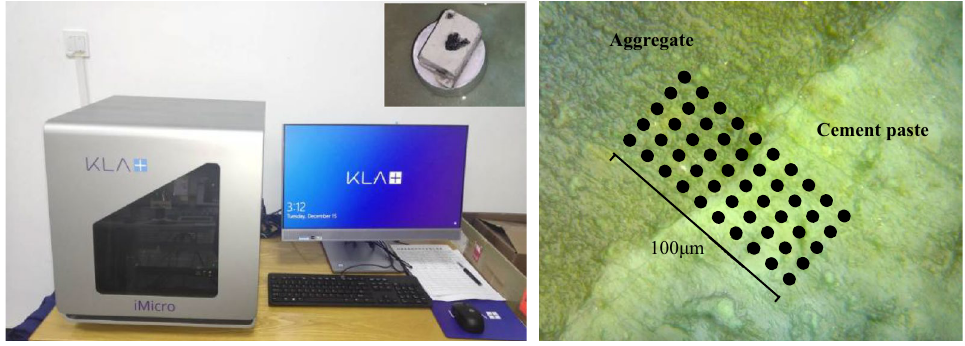
(a) Nano-indenter (b) Test dot-matrix diagram